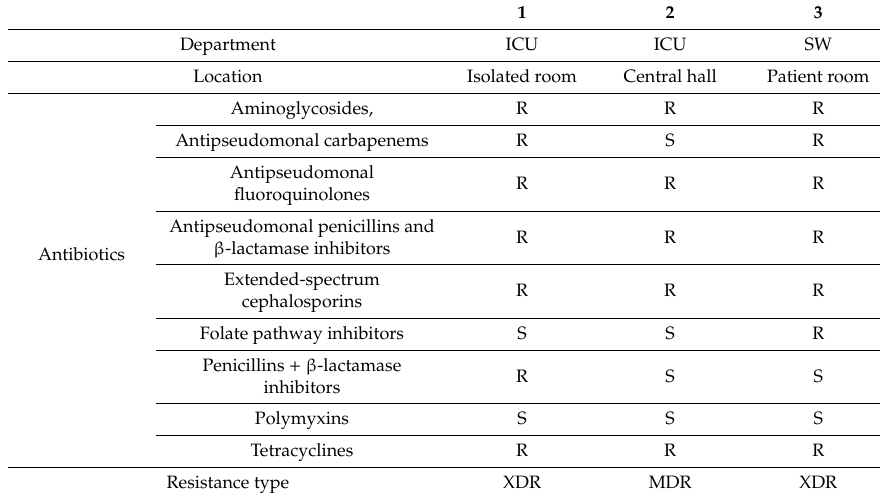
Table 5. Results of Sensitivity Tests for MDR and XDR A. baumanii.